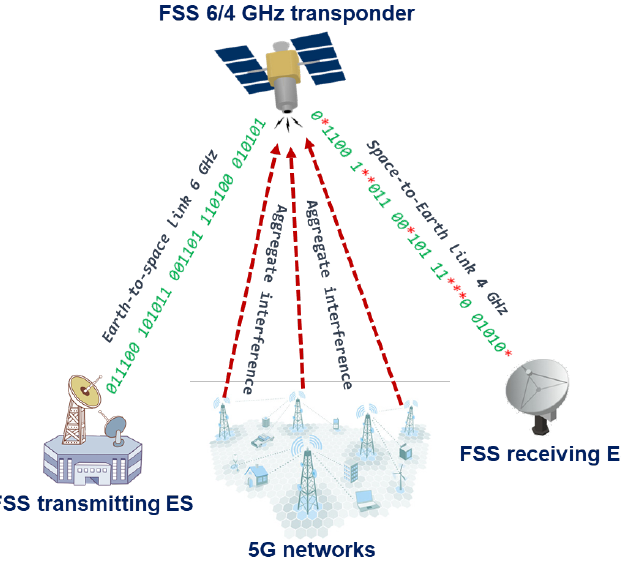
Figure 1. Typical scenario of aggregate interference to the bent pipe satellite link.